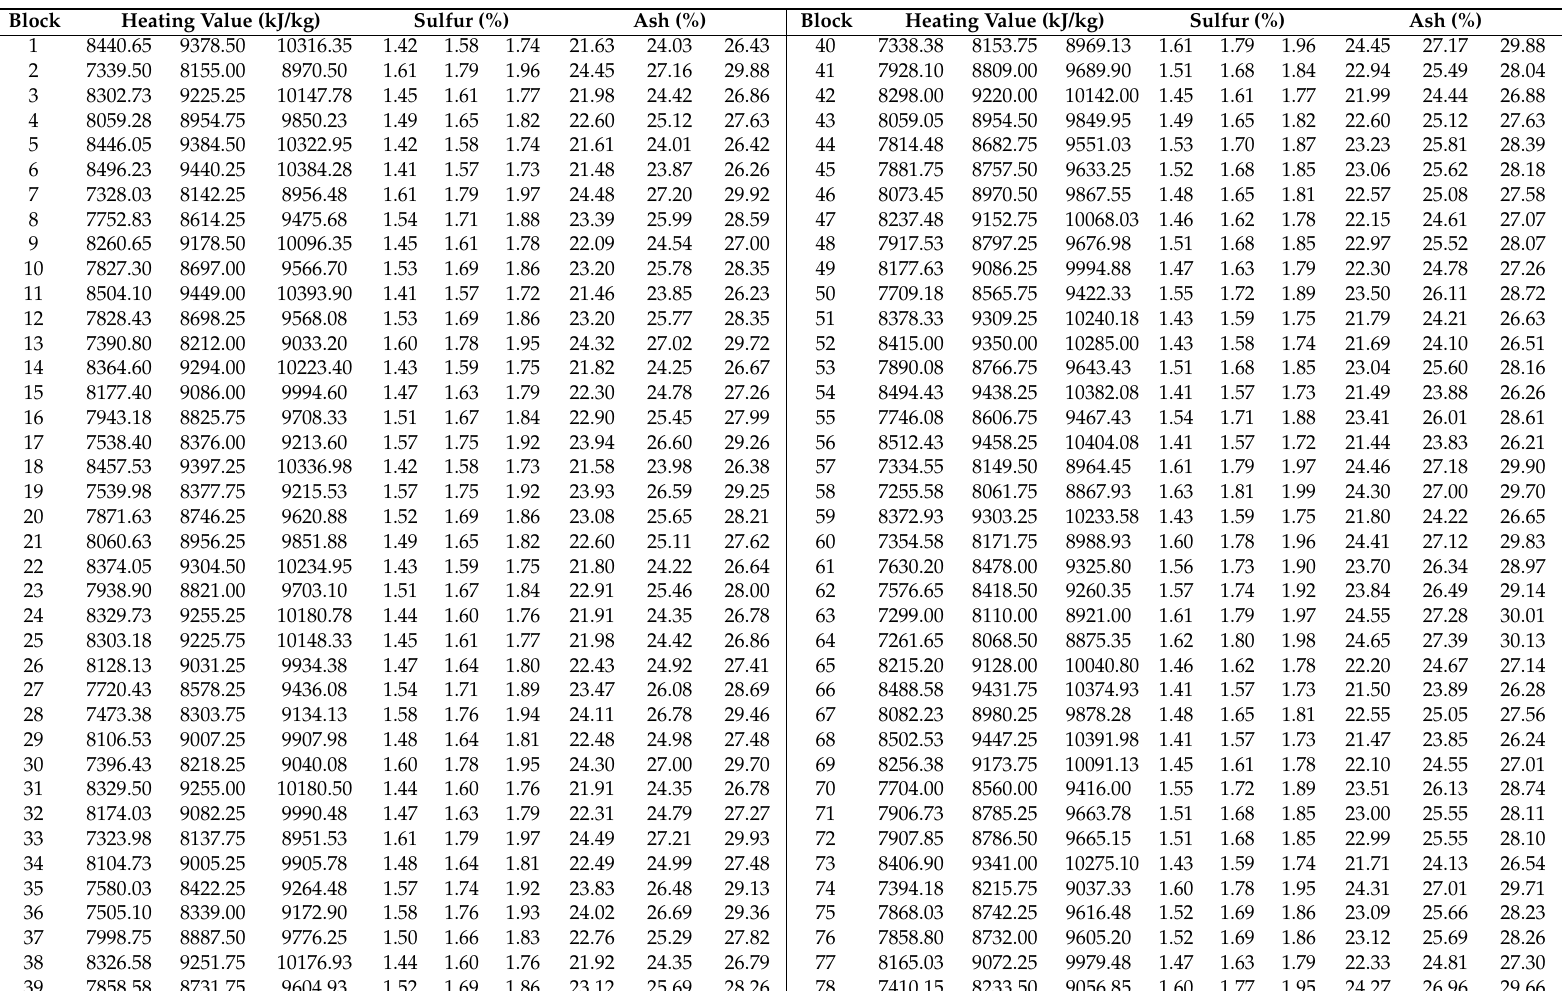
Table 1. Attributes of the mineable coal